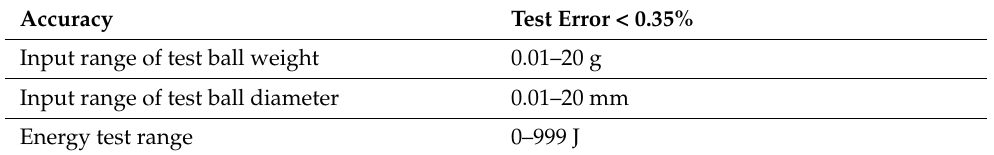
Table 4. Error and measurement range of the velocity measuring equipment.